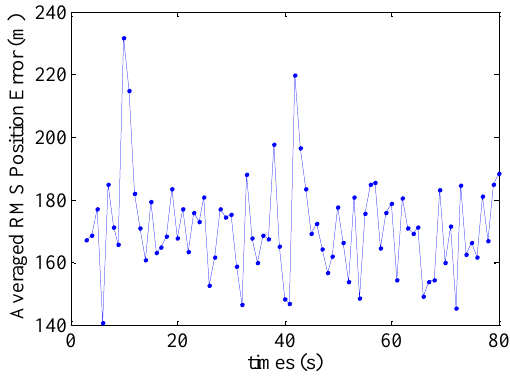
Figure 15. The estimated error for the target III.